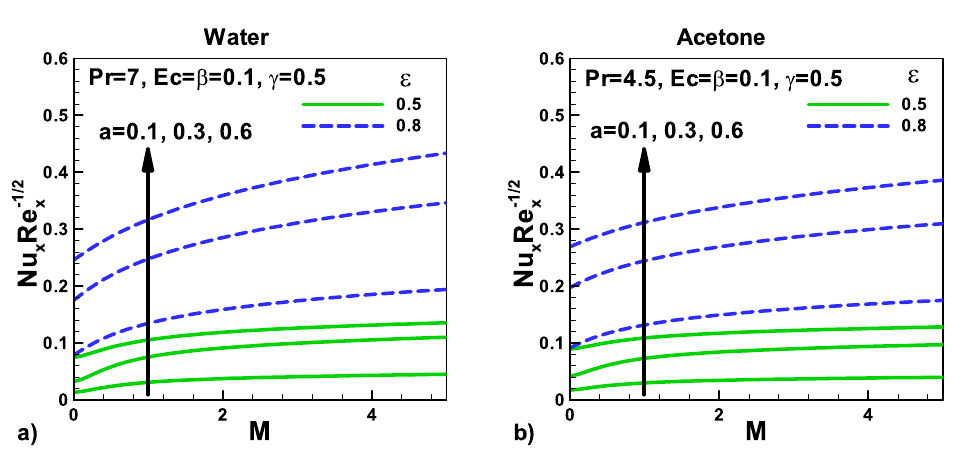
Figure 7. Variation of Nusselt number with magnetic field and velocity ratio parameter at different positions for ( a ) water ( b )